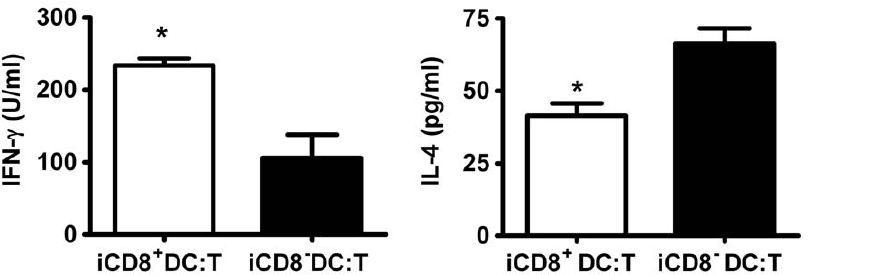
Figure 3. iCD8 + DC and iCD8 2 DC subsets generate different patterns of BCG-driven T cell cytokine production. BCG-specific CD4 + T cells (5 6 10 5 ) cell from BCG-infected mice were co-cultured with iCD8 + DC or iCD8 2 DC (5 6 10 4 cells/well) in the presence of HK-BCG. Culture supernatants were collected at 72 h. IFN- c and IL-4 were measured by ELISA. The experiment was repeated twice showing similar results. *p , 0.05.